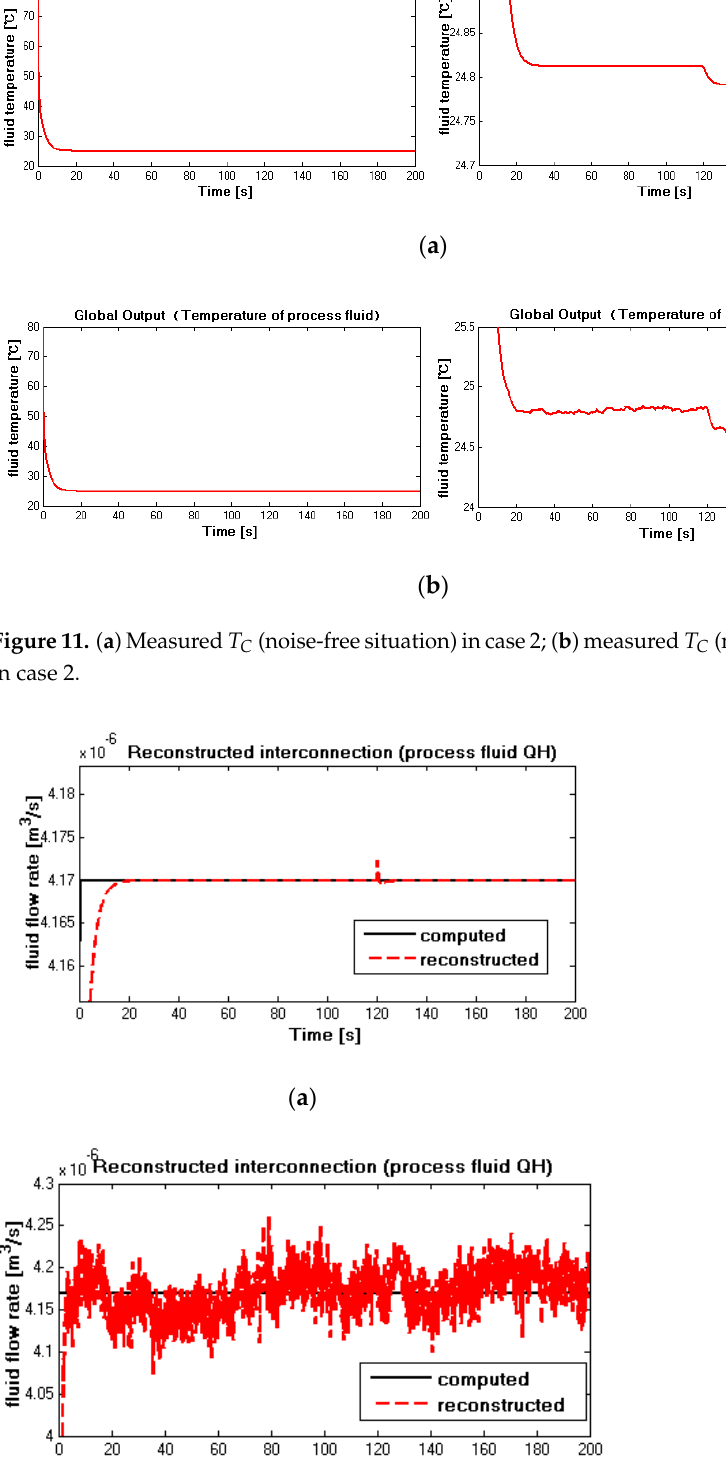
Figure 10. ( a ) Measured (cid:1846) (cid:3009) (noise-free situation) in case 2; ( b ) measured (cid:1846) (cid:3009) (noise-corrupted situation) in case 2.